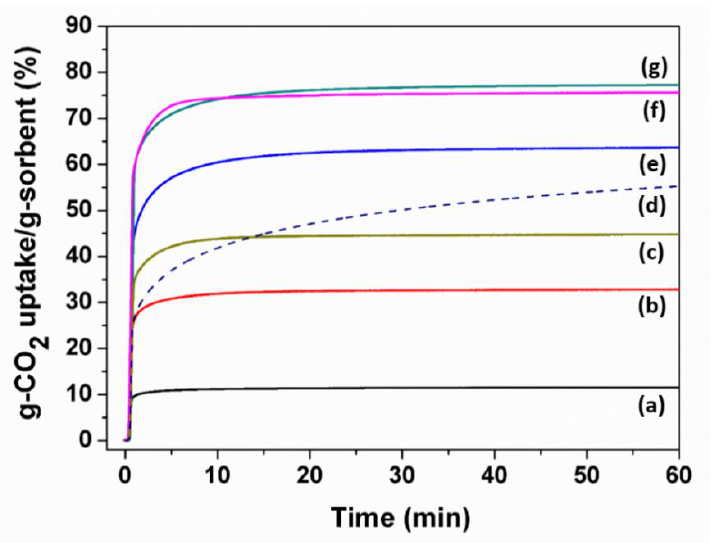
Figure 3. CO 2 capture capacity at 700 °C for ( a ) Ca 0.3 Mg 0.7 -MOF-O, ( b ) Ca 0.6 Mg 0.4 -MOF-O, ( c ) Ca 0.75 Mg 0.25 -MOF-O, ( d ) Commercial CaO, ( e ) Ca 0.85 Mg 0.15 -MOF-O, ( f ) Ca 0.97 Mg 0.03 -MOF-O, and ( g ) Ca-MOF-O.